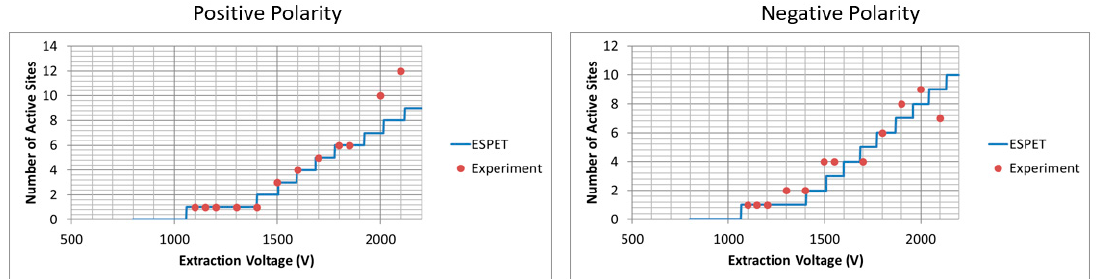
Figure 22. Active number of emission sites versus extraction voltage. Data are compared to empirical ESPET model.